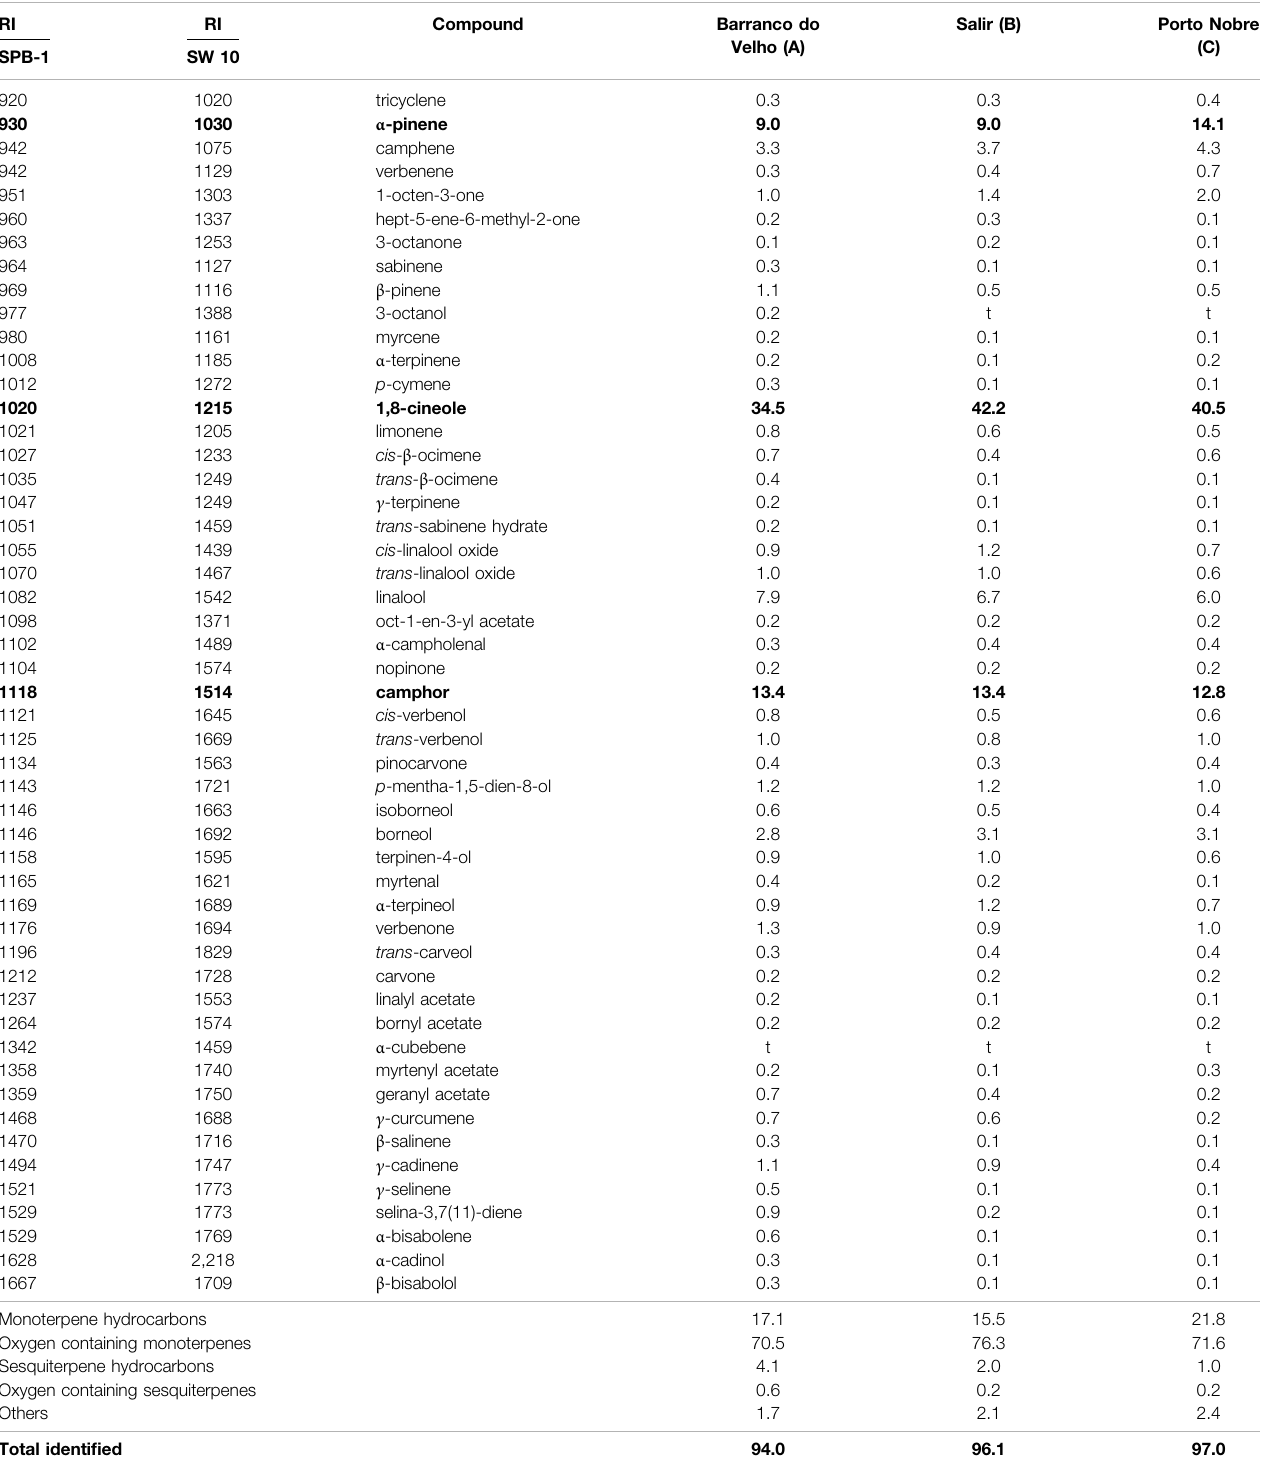
Salir (B) Porto Nobre Velho (A)